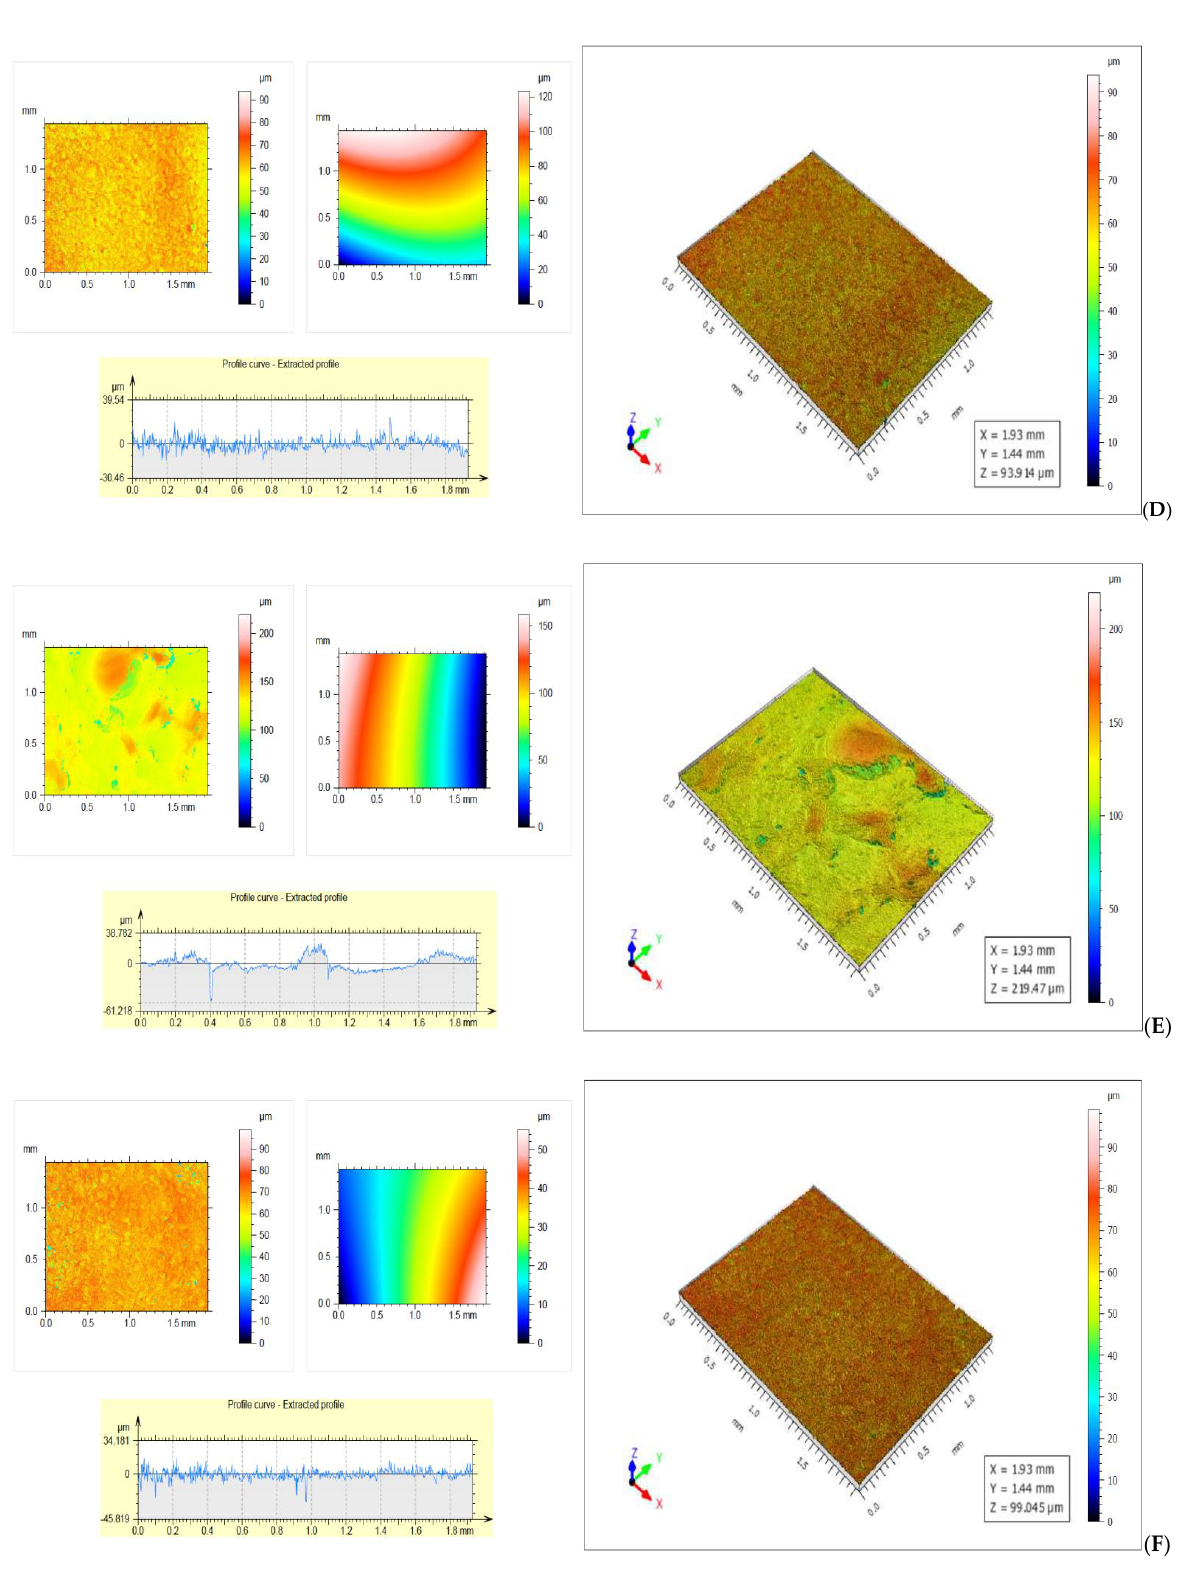
Figure 6. ( A )—Rough surface of SCa4 sample—Rt = 33.813 µ m; ( B )—Glossy surface of SCa4 sample— Rt = 30.117 µ m; ( C )—Rough surface of SAA1 sample—Rt = 49.865 µ m; ( D )—Glossy surface of SAA1 sample—Rt = 34.987 µ m; ( E )—Rough surface of Control sample—Rt = 70.335 µ m; ( F )—Glossy surface of control sample—Rt = 38.357 µ